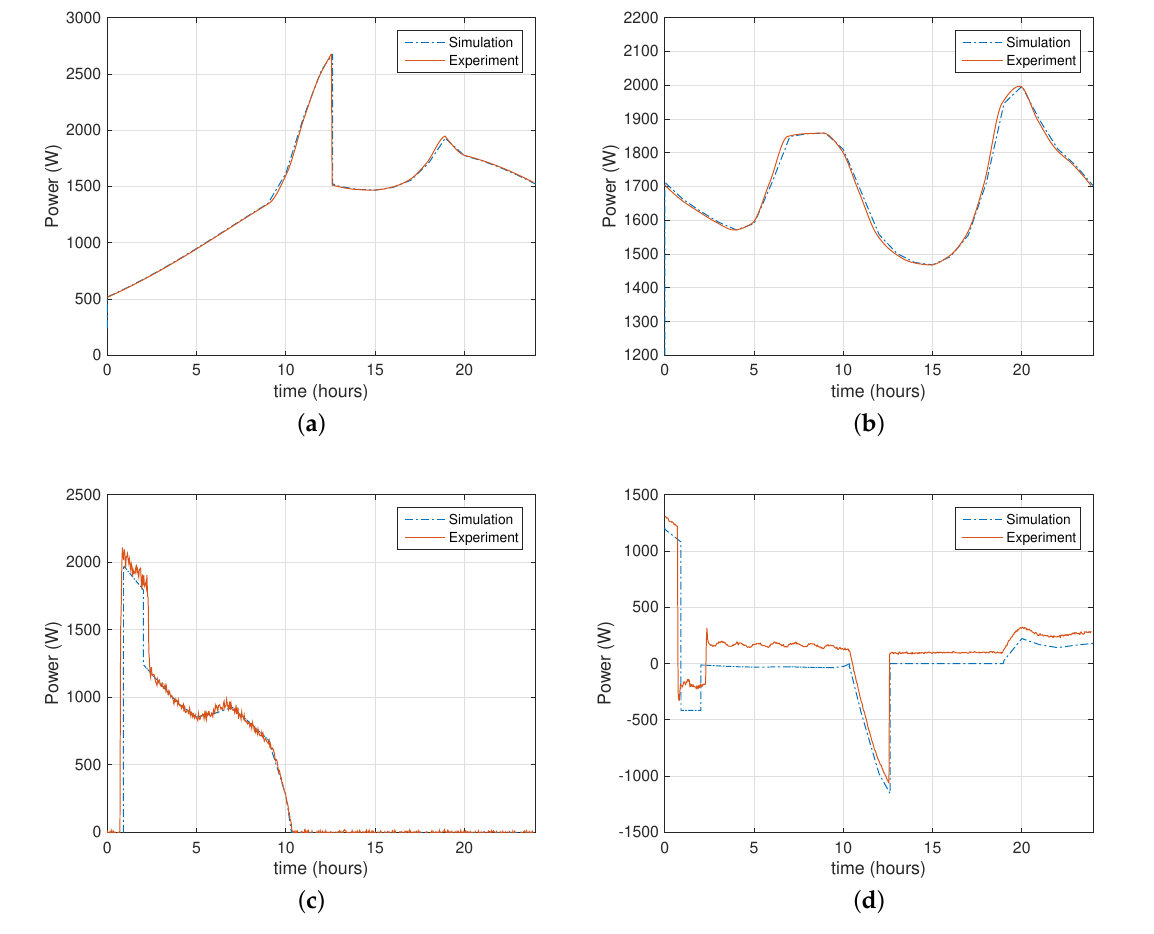
Figure 13. Dashed lines: simulated profiles; solid lines: experiment results: ( a ) RES generation; ( b ) load power demand; ( c ) Nexa TM fuel cell; ( d ) Maxwell TM